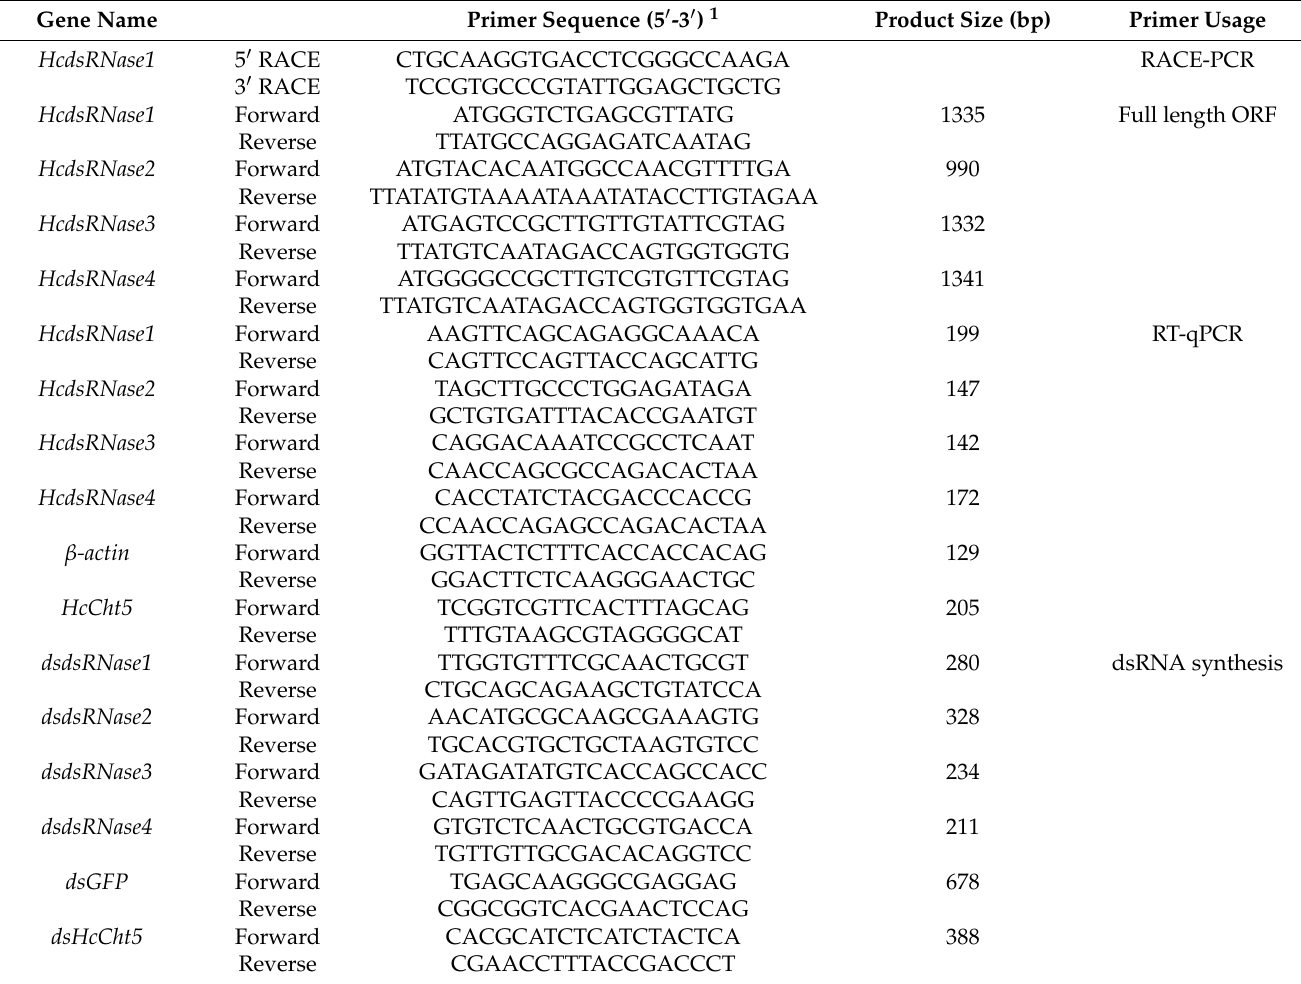
Table 3. Primer sequences used in this